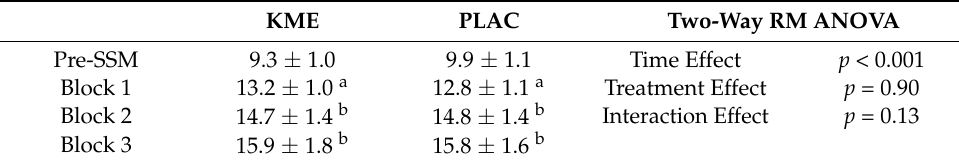
Table 1. Ratings of perceived exertion (RPE).